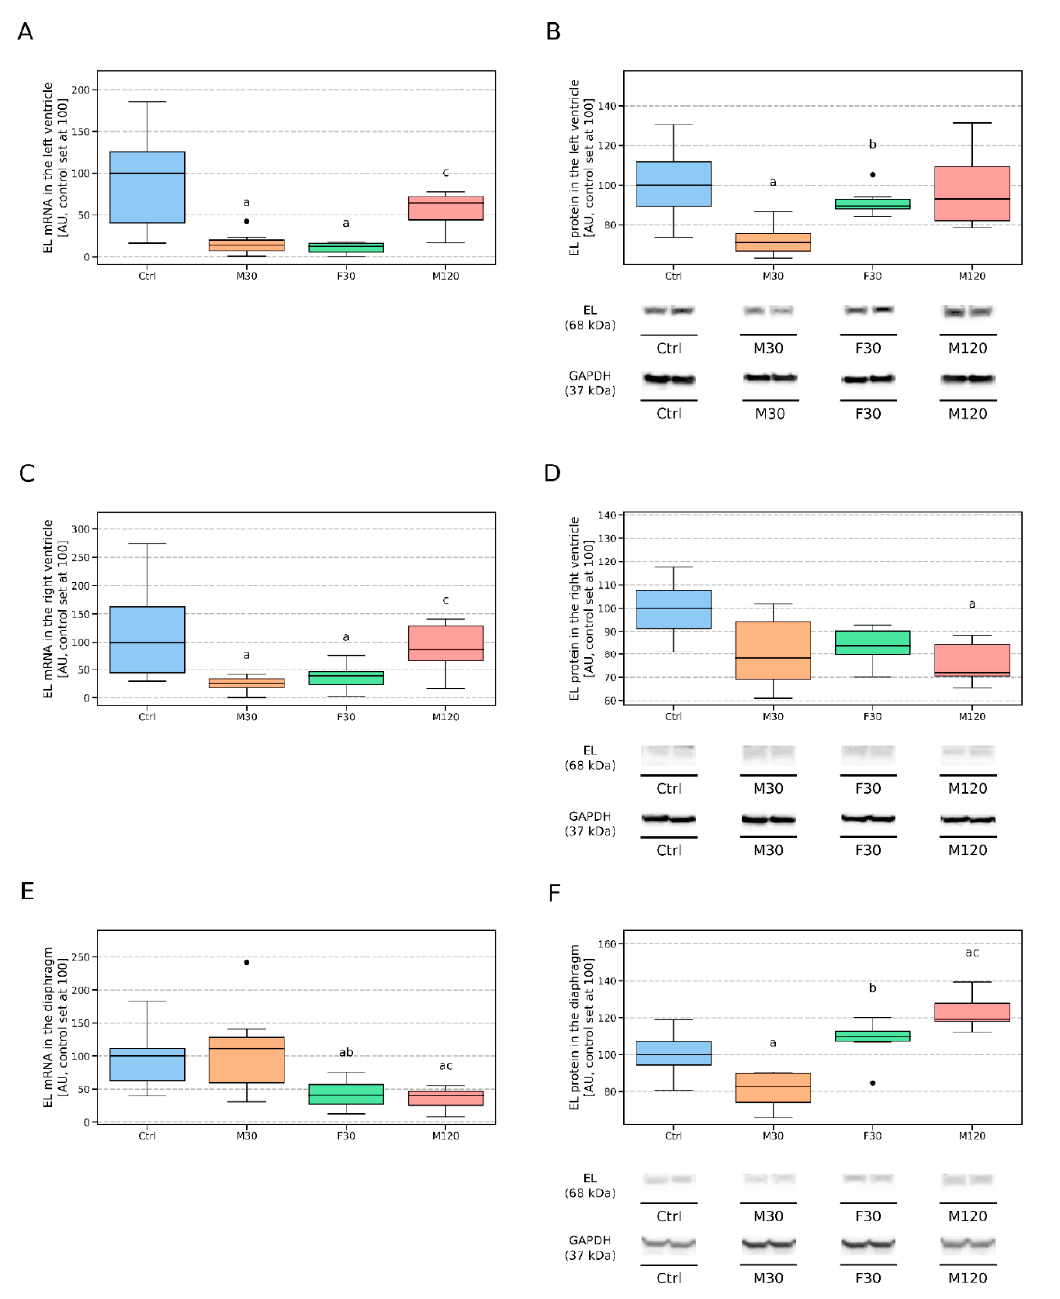
Figure 2. Endothelial lipase (EL) gene and protein expression in the vascular beds of the left ventricle ( A , B ), the right ventricle ( C , D ) and the diaphragm ( E , F ) in response to a treadmill run. The inner horizontal line of a box represents the median. Box boundaries: 25–75 percentile. Box whiskers: 1.5 interquartile range or max/min value in the group. Solid black dot—data point laying outside 1.5 * IQR (the interquartile range). Representative Western blots images are shown. a—difference vs. control (Ctrl), p < 0.05; b—difference F30 vs. M30, p < 0.05; c—difference M120 vs. M30, p < 0.05, n = 6 per